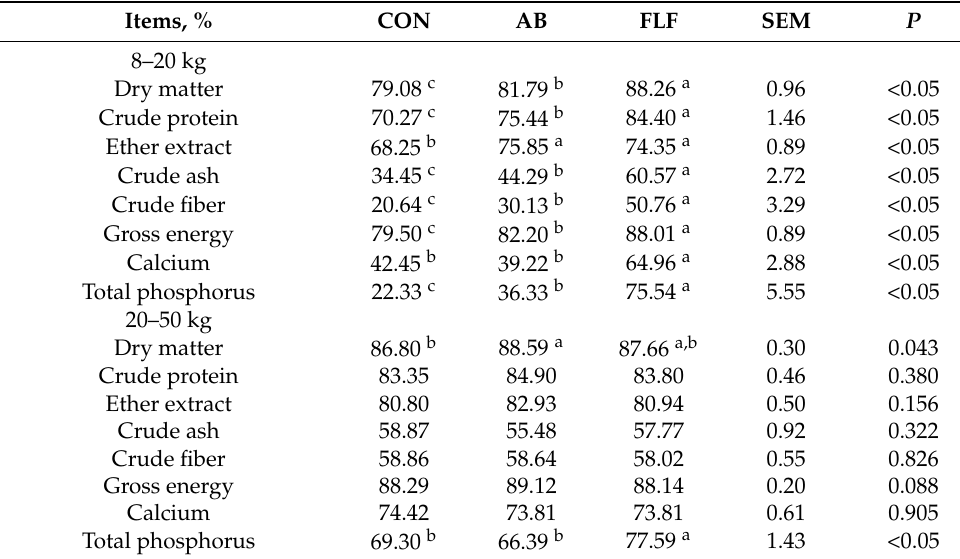
Table 5. Effects of fermented liquid feeding on the nutrition ATTD of